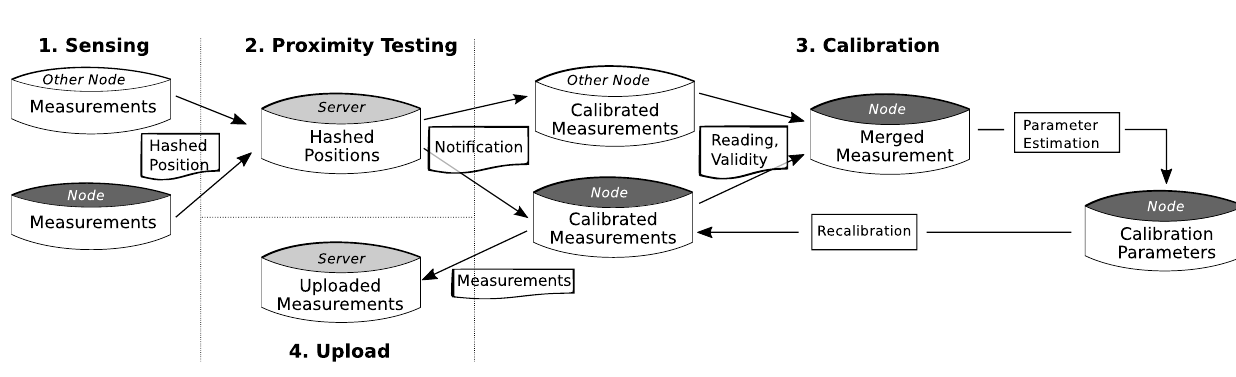
Figure 1. Calibration pipeline: Rendezvous are matched by the server and the sensor nodes’ respective measurements and validities are merged to calibration tuples. The nodes estimate the calibration parameters by linear regression and recalibrate the measurements accordingly. Finally, the measurements are uploaded to the